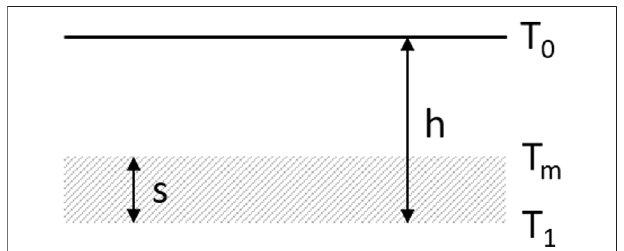
FIGURE 2 | Schematic representation of mold powder/slag layers on top of the steel meniscus in the mold.